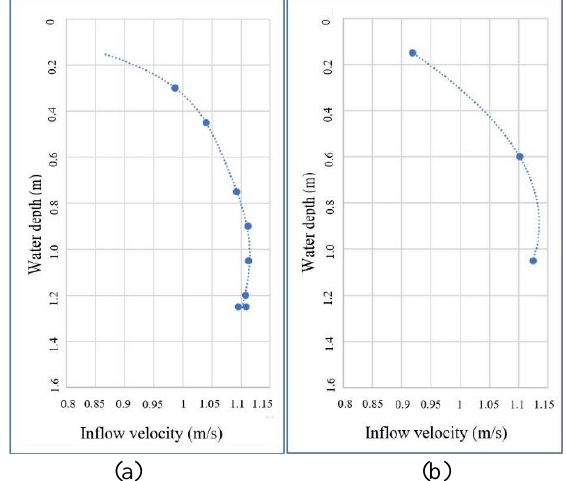
Figure 1. Inflow profiles for RW1 amd NRW1. (a) is RW1 as the